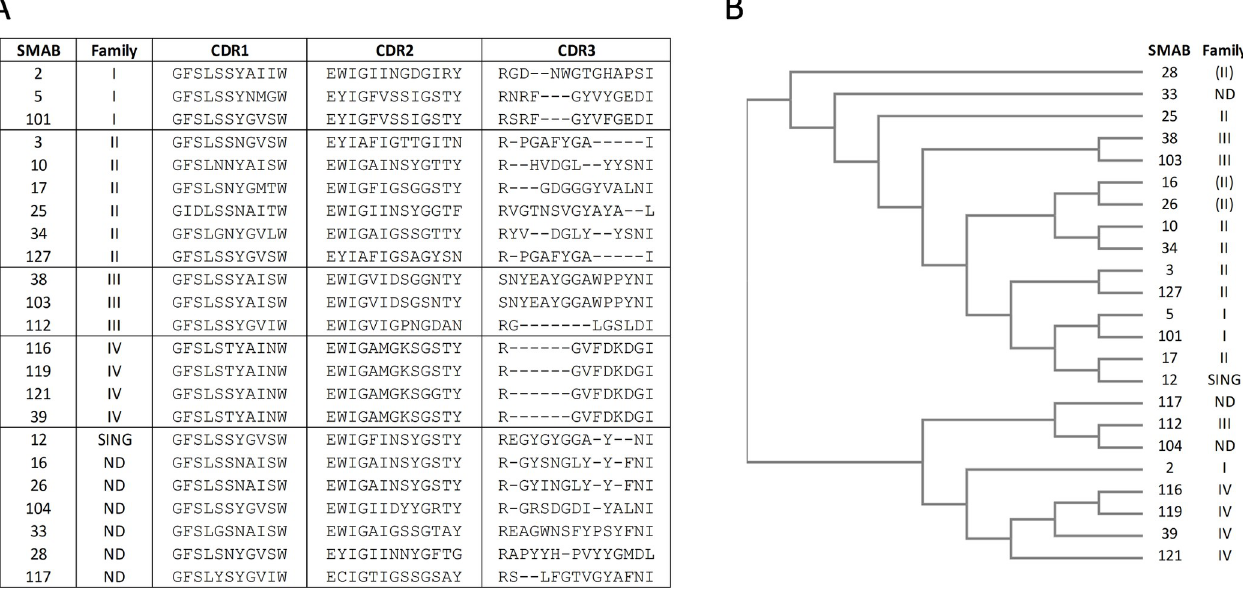
PLOS ONE | https://doi.org/10.1371/journal.pone.0267046 April 22,